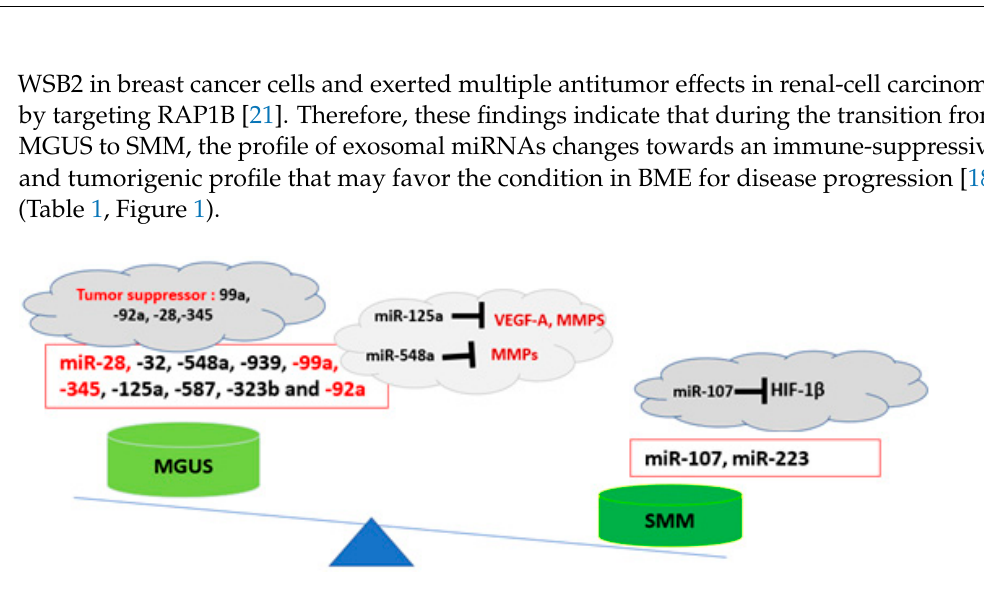
Figure 1. Exosomal miRNAs profile in the pathogenesis of MM. During the progression of MGUS to SMM, the profile of exosomal miRNAs changes towards an immune-suppressive and tumorigenic profile [18] .